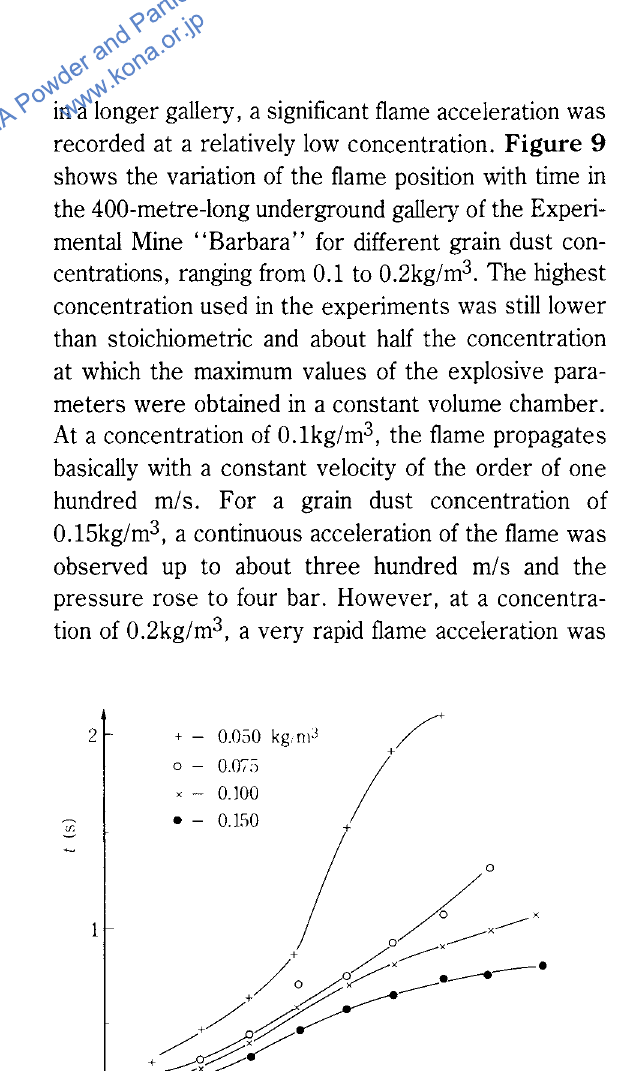
Diagram showing variation of the flame position with time along a 100-rnetre-long gallery for different grain dust concentrations. Initiator-10 rn3 of CH 4 -air mixture; length of dust zone: 60 rn